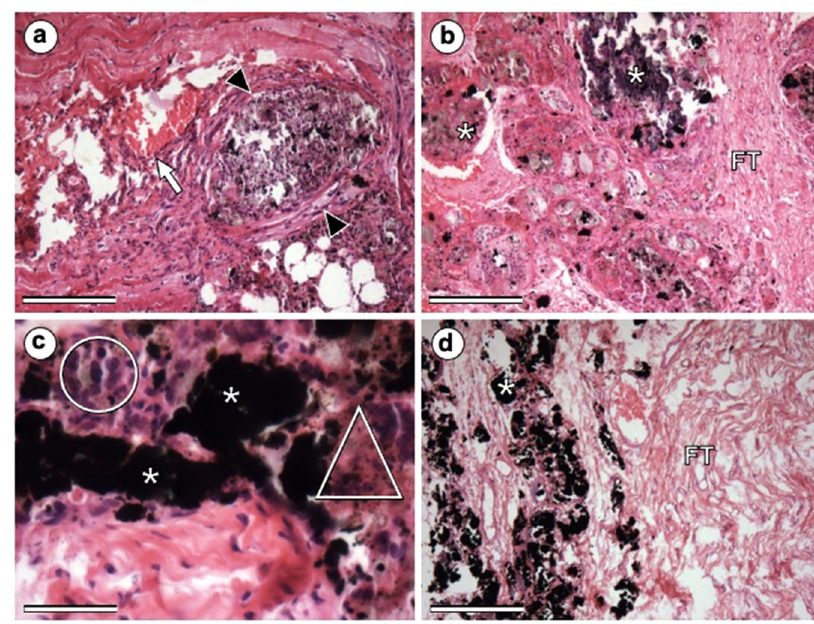
Fig. 5 Photomicrographs at 15 ( a ), 30 ( b ), 70 ( c ), and 100 ( d ) days after implantation of the materials. ( a ), ( b ) and ( c ) HC; ( d ) C γ . Asterisk: biomaterial; arrowhead: fi brous capsule; triangle: hemosiderin deposit; circle: in fl ammatory in fi ltrate; FT: organized fi brous tissue (collagen fi bers). ( a ), ( b ), and ( d ):100x; ( c ): 400x. HE. Bars: 40